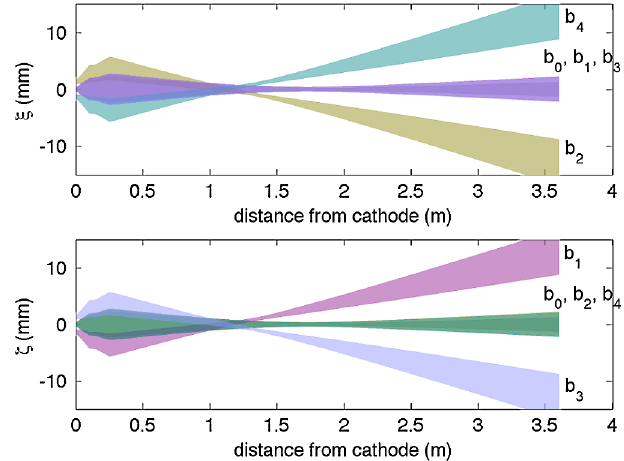
FIG. 8. (Color) Beamlets’ transverse rms envelopes and trajec- tories in the ð z; (cid:10) Þ (top) and ð z; (cid:11) Þ (bottom) for ^ B ¼ 0 : 376 T . The b i labels correspond to the beamlets shown in Fig. 7